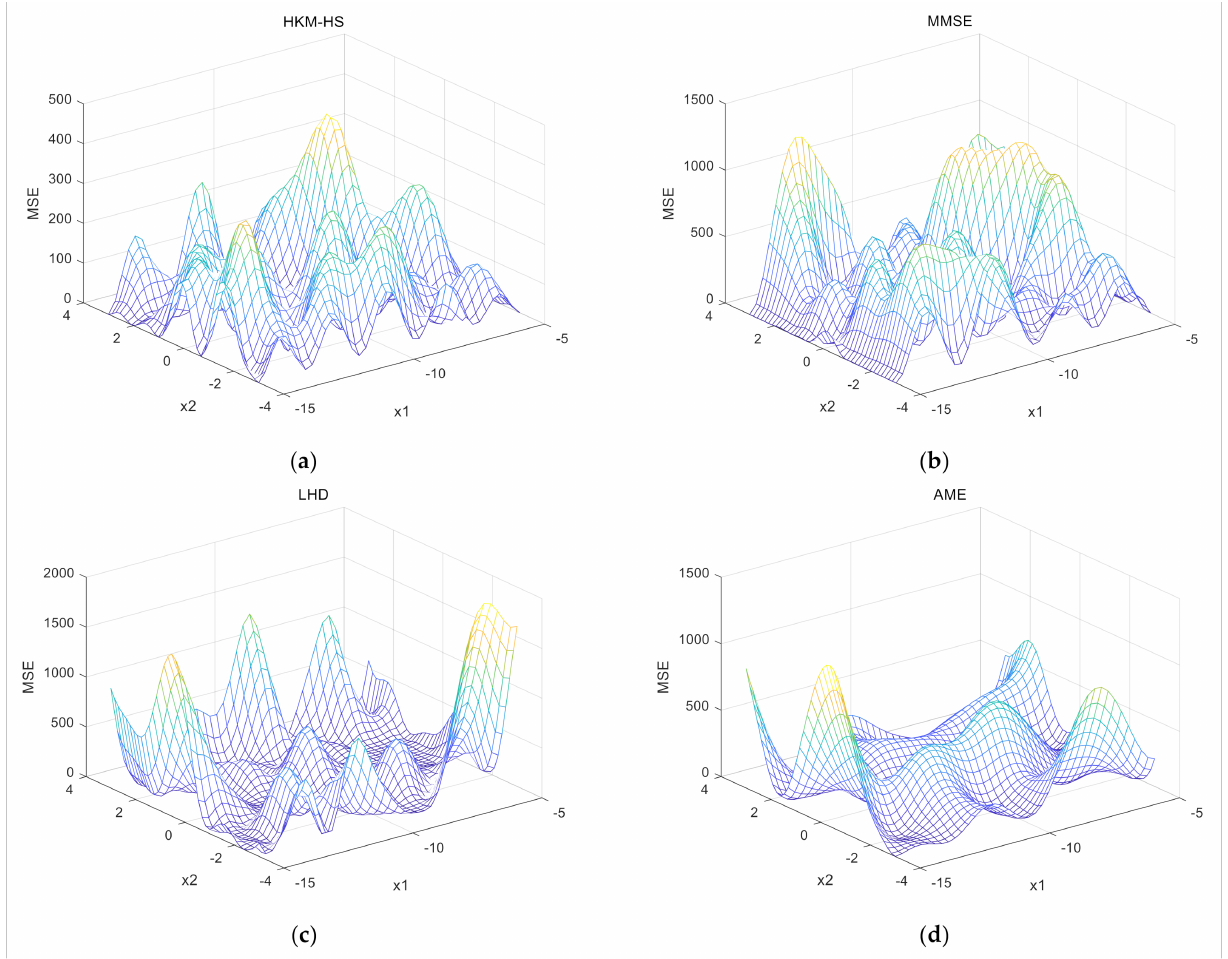
Figure 4. ( a )Test result of Bukin function by HKM-HS; ( b ) Test result of Bukin function by maximum mean square error (MMSE); ( c ) Test result of Bukin function by Latin Hypercube Design (LHD); ( d ) Test result of Bukin function by adaptive maximum entropy